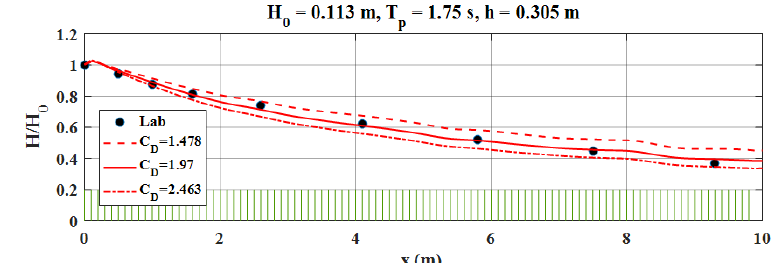
Figure 10. Example of the sensitivity test on the drag coefficient, C D . Symbol: laboratory data. Solid: simulation using C D calculated by (6). Dashed and dotted: simulations with ± 25% difference in the value of C D . The maximum differences in wave height for C D = 1.478 and 2.463 are 9.4% and 7.1%, respectively.